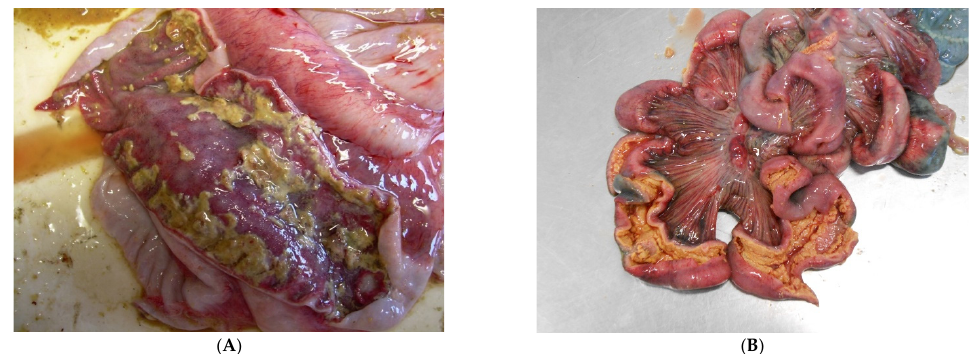
Figure 18. Fibrinous enteritis with involvement of colon ( A ) and small intestine ( B ) in pigs infected with S. Typhimurium. The affected intestinal segments involved typically have: